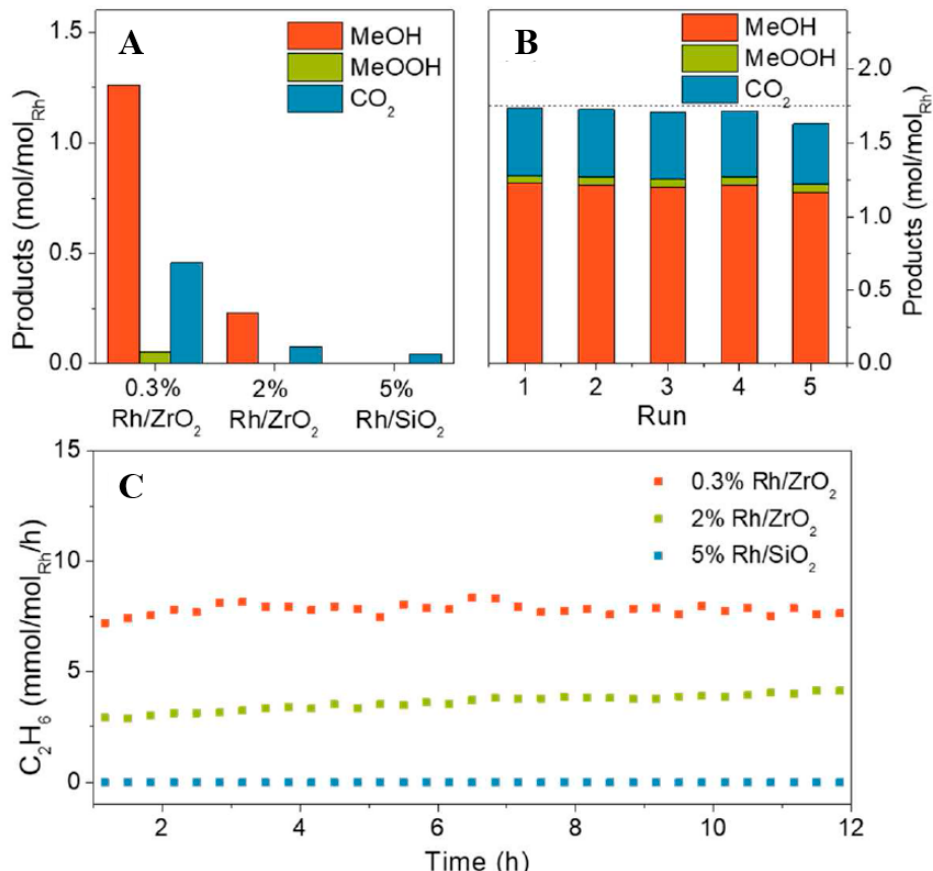
Figure 11. ( A ) Direct CH 4 oxidation results using H 2 O 2 as oxidant in aqueous solution on 0.3 wt% Rh/ZrO 2 , 2 wt% Rh/ZrO 2 , and 5 wt% Rh/SiO 2 catalysts. ( B ) Recyclability test results performed with the 0.3 wt% Rh/ZrO 2 catalyst. Reaction condition—30 bar of 95%CH 4 /He, 70 °C, 1 h, 0.5 M H 2 O 2 and catalyst 30 mg. ( C ) Direct CH 4 conversion to C 2 H 6 using O 2 as oxidant in gas ‐ phase on 0.3 wt% Rh/ZrO 2 , 2 wt% Rh/ZrO 2 and 5 wt% Rh/SiO 2 catalysts. Reaction condition: 9.85 sccm of 91%/0.3%/8.7% CH 4 /O 2 /N 2 , 260 °C atmospheric pressure, and catalyst 0.15 g. Reproduced with permission from [30]. Copyright 2017 American Chemical Society.